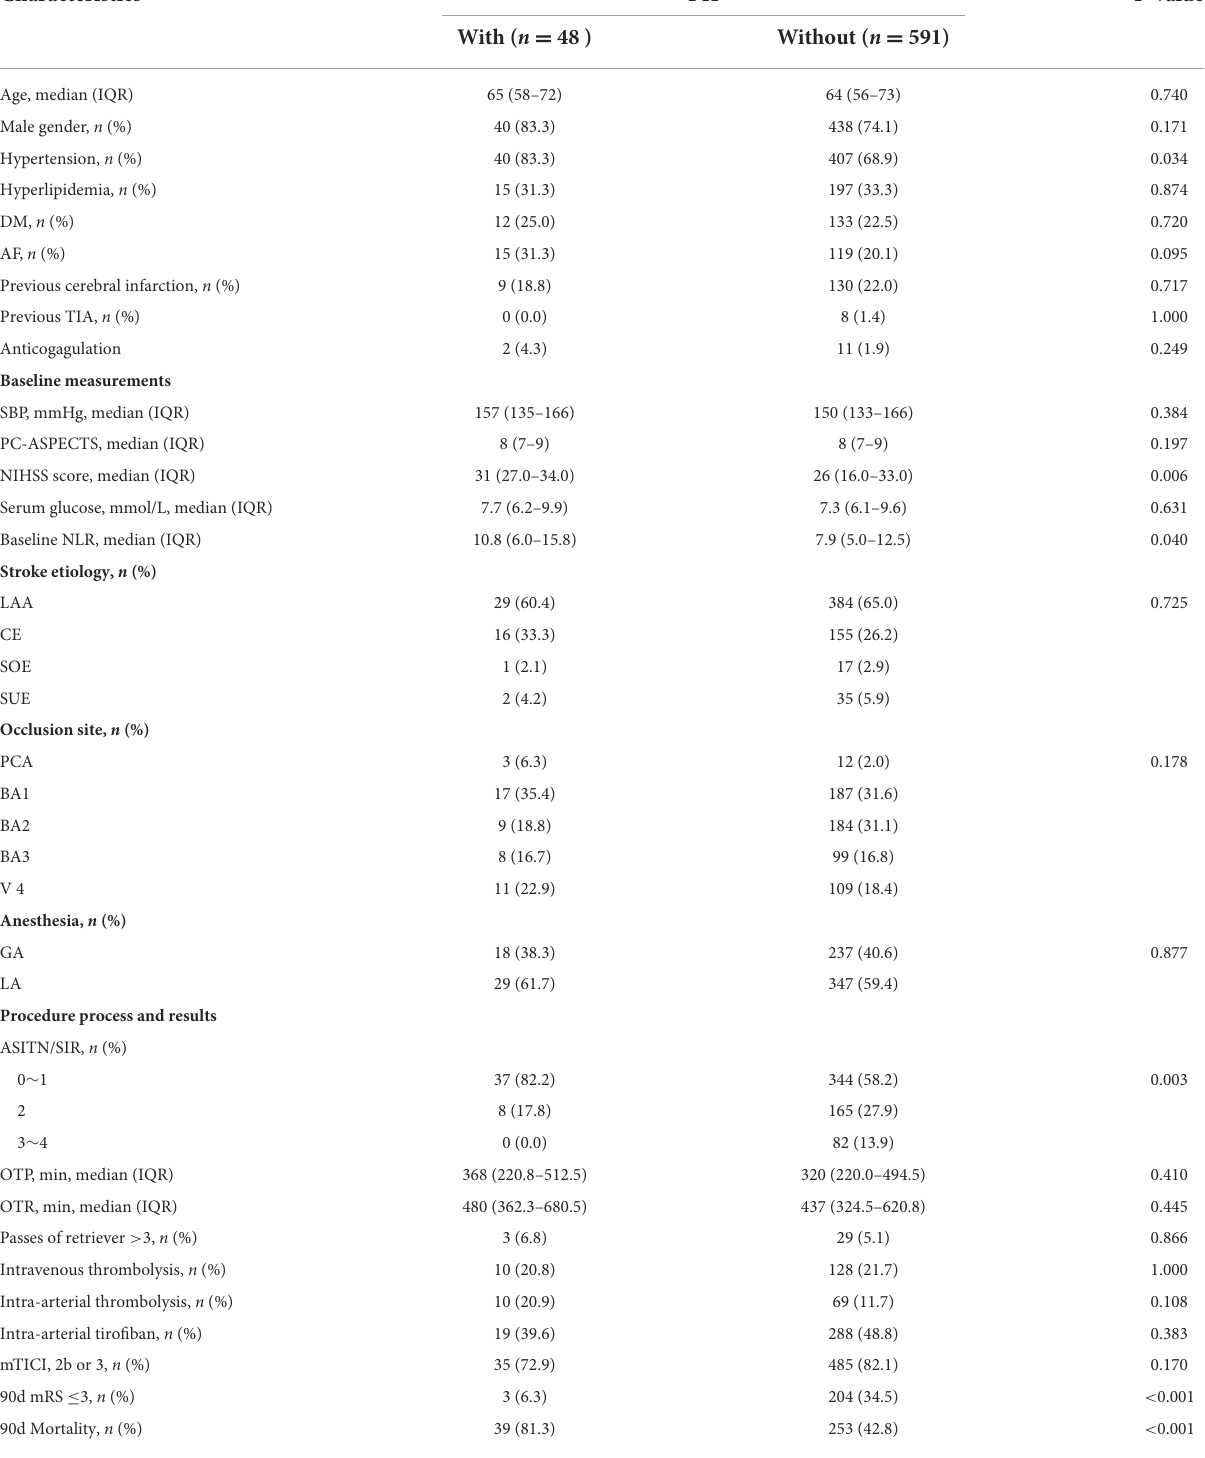
TABLE 1 Baseline characteristics and outcomes of patients with and without PH.